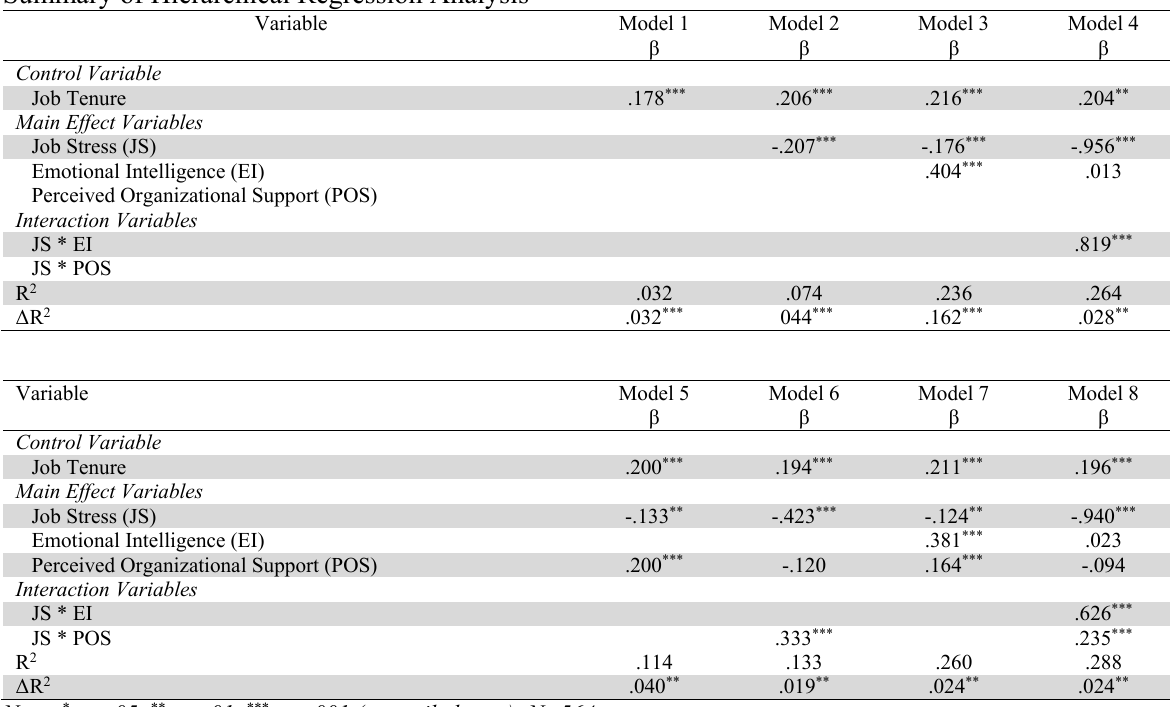
Summary of Hierarchical Regression